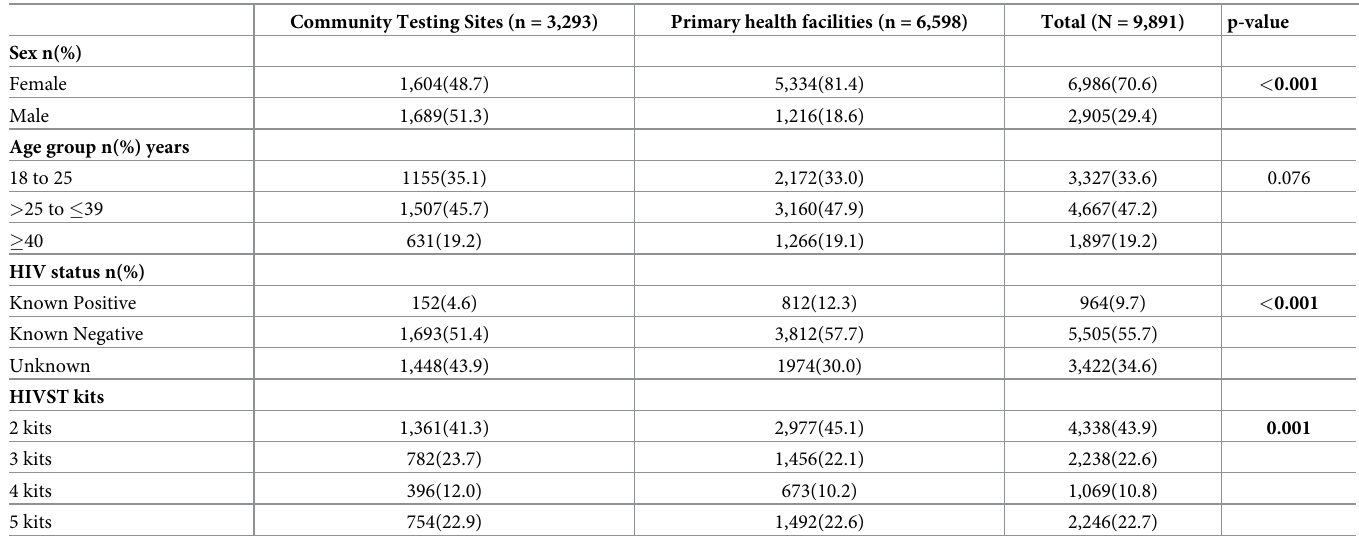
Table 2. Characteristics of primary recipients at distribution